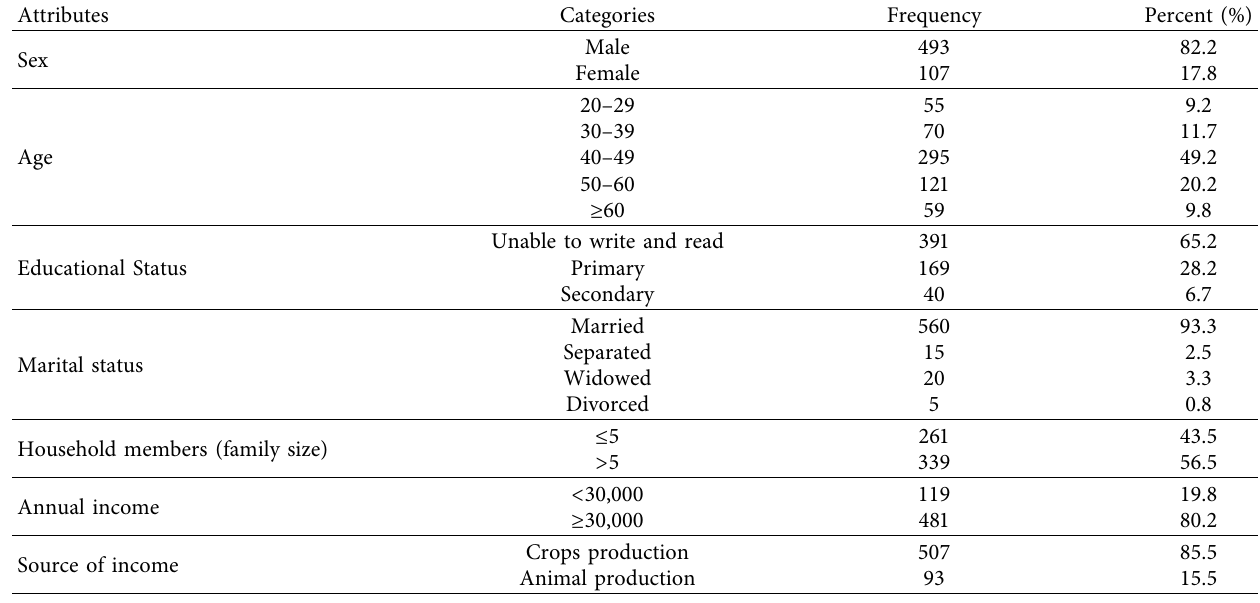
Table 1: Sociodemographic and socioeconomic characteristics of respondents, Akaki District, 2021.